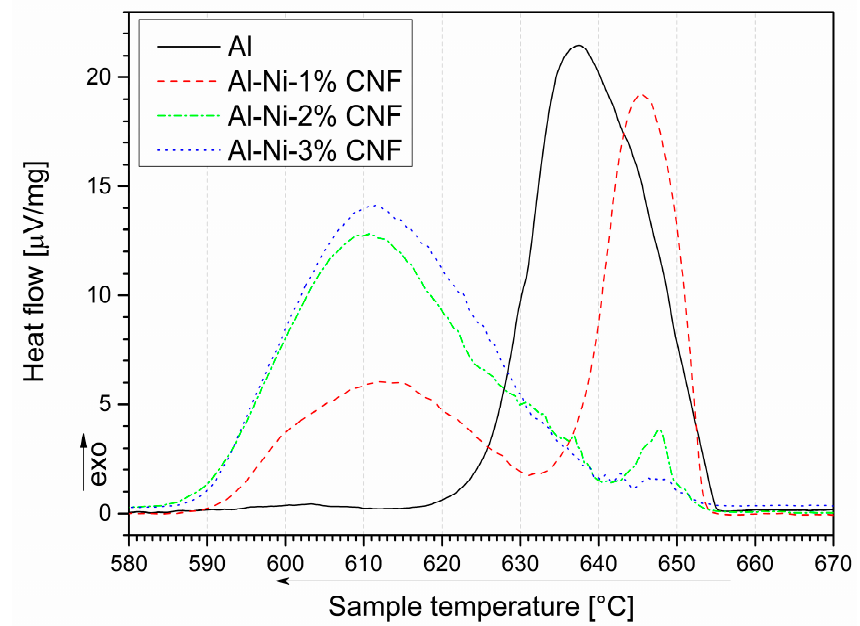
Figure 3. DSC curves of aluminum with various CNF content during cooling near Al melting point.